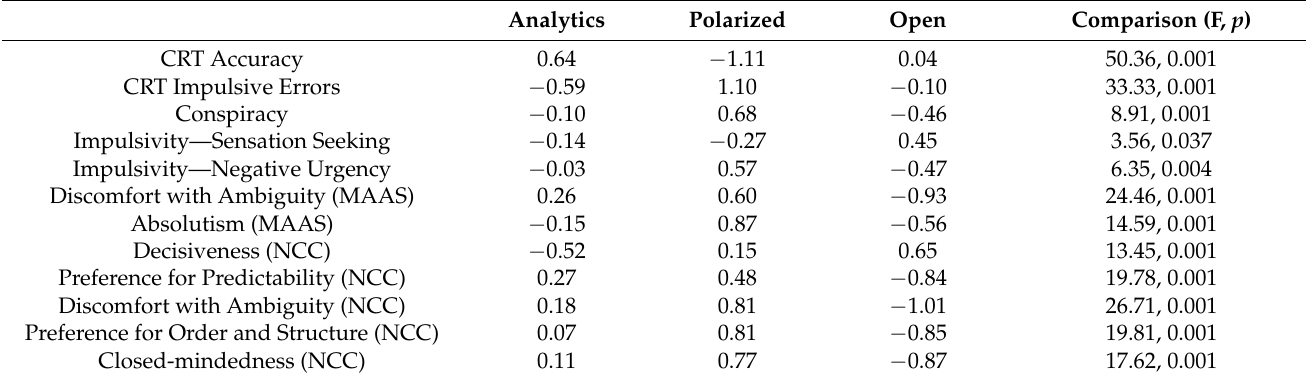
Table 2. Cognitive and behavioral dimensions z-scores for the final 3-cluster solution, and their comparison between the classified